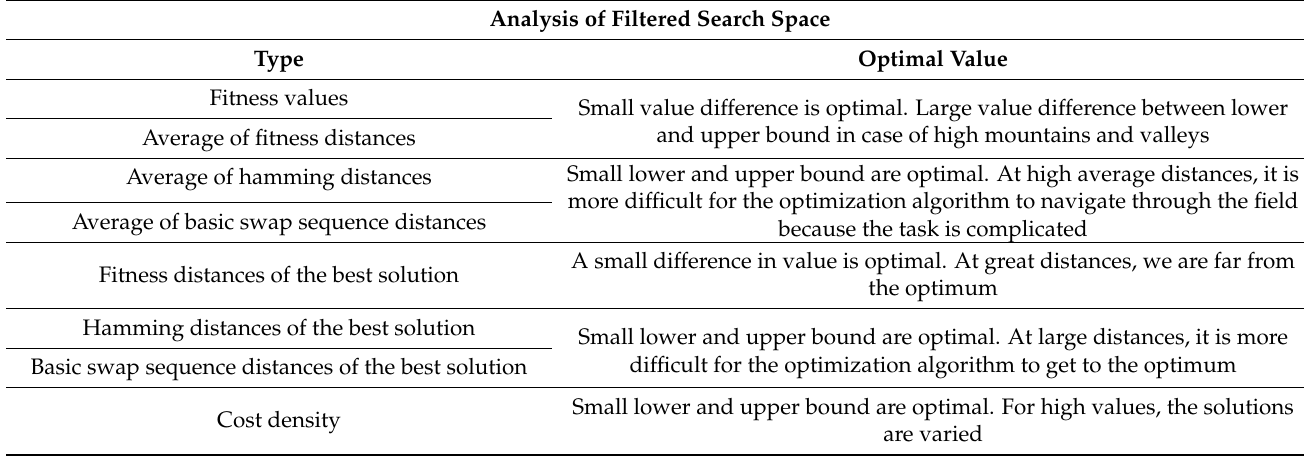
Figure 7. The basic swap sequence distance of solutions. Table 1. Analysis of the scattered filtered search space: meaning of evaluation.